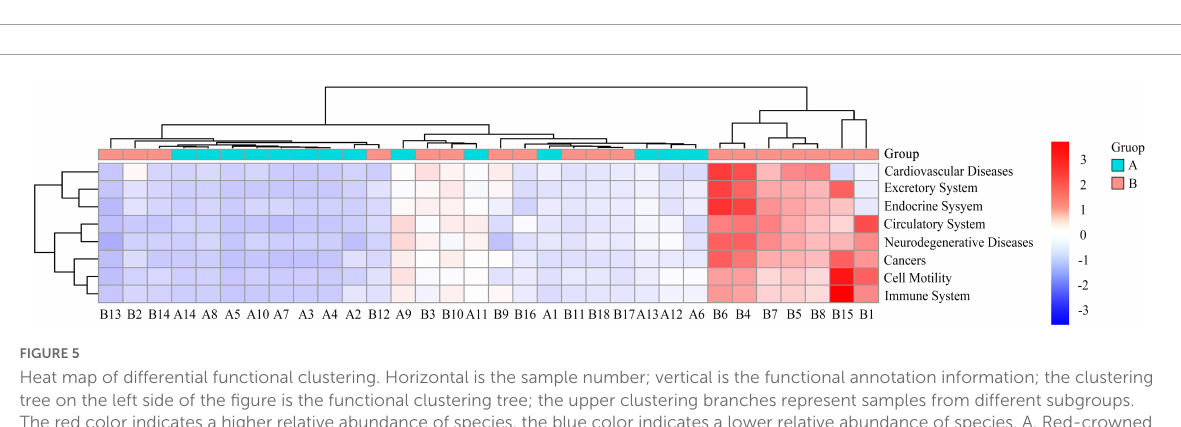
FIGURE4 PCoA analysis graph of the colony. The same color in the graph is the same grouping. PC1 and PC2 are the first and second principal coordinates with the greatest explanation of the difference between samples.